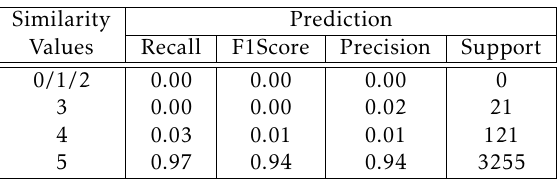
the same using double-LSTM and dynamic CNN techniques. Semantic likeness estimation between